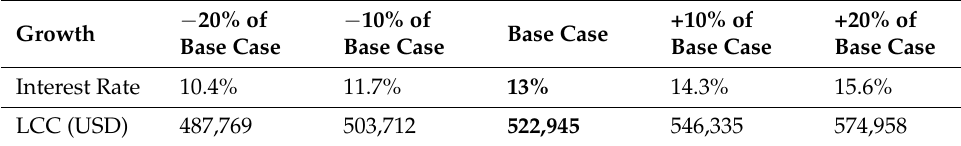
Table 14. Optimal configuration results with interest rate variation.